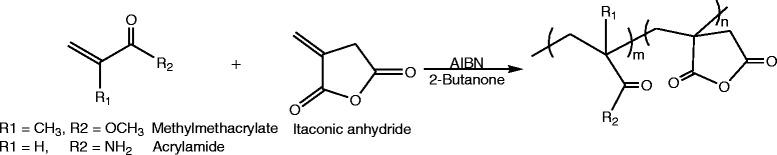
Copolymerization of itaconic anhydride with acrylic monomers.